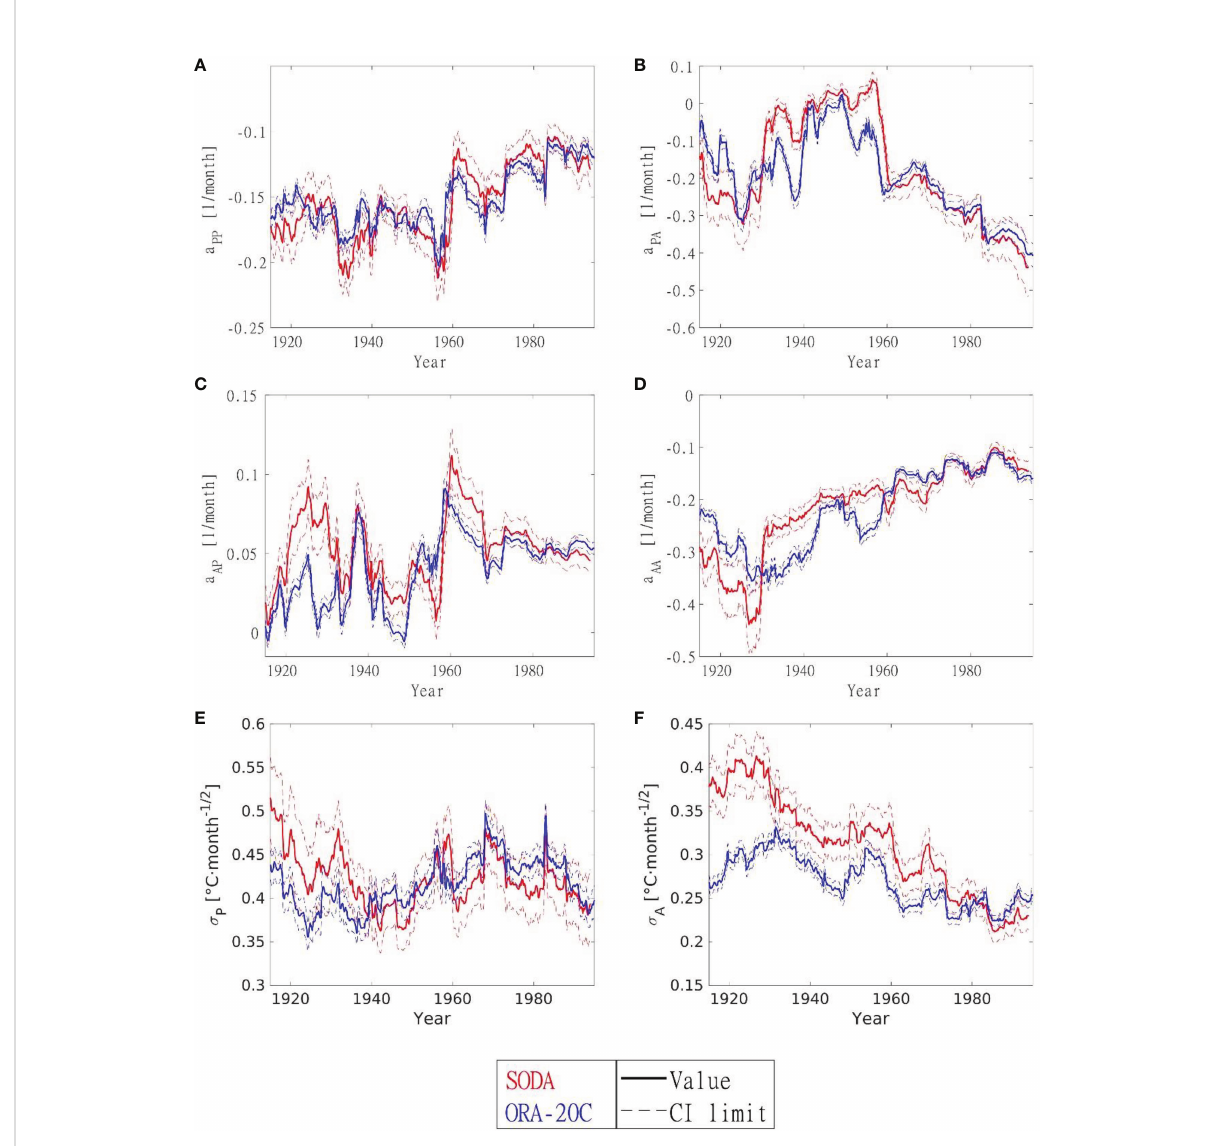
FIGURE 6 Parameter evolution computed with the ReOsc+ model for Atlantic-Paci fi c SST system (Eq. 8 fi tted as explained in Section 2.3): Damping rates (a PP and a AA ), couplings (a PA and a AP ) and noise amplitudes ( s P and s A ) in the period 1900-2008 for SODA (red) and in the period 1900-2009 for ORA-20C (blue) reanalysis. (A) Damping rate of the Paci fi c SST anomaly (a PP ). (B) Coupling of the Paci fi c to the Atlantic SST anomalies (a PA ). (C) Coupling of the Atlantic to the Paci fi c SST anomalies (a AP ). (D) Damping rate of the Atlantic SST anomaly (a AA ). (E) Noise amplitude directly affecting the Paci fi c SST anomaly. (F) Noise amplitude directly affecting the Atlantic SST anomaly. Each point of the fi gure considers a time window of 30 years, and the represented year in the horizontal axis is the mean value of that interval. Solid lines represent the parameter ’ s value, and dashed lines show the (1-standard-deviation) con fi dence intervals (Supplementary Appendix